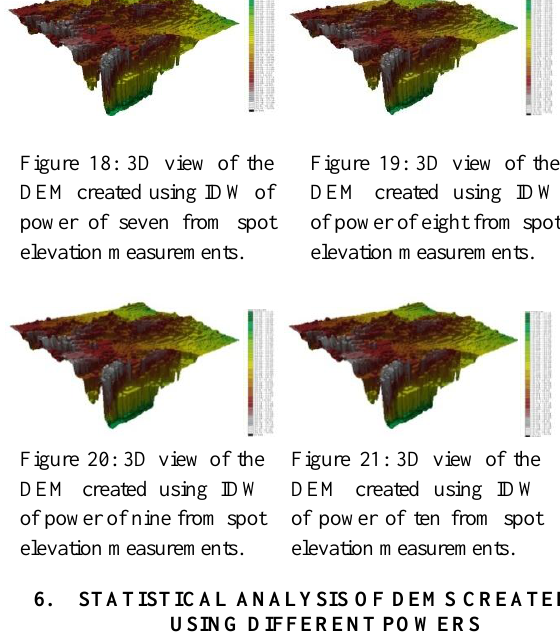
Figure 20: 3D view of the DEM created using IDW of power of nine from spot elevation measurements.